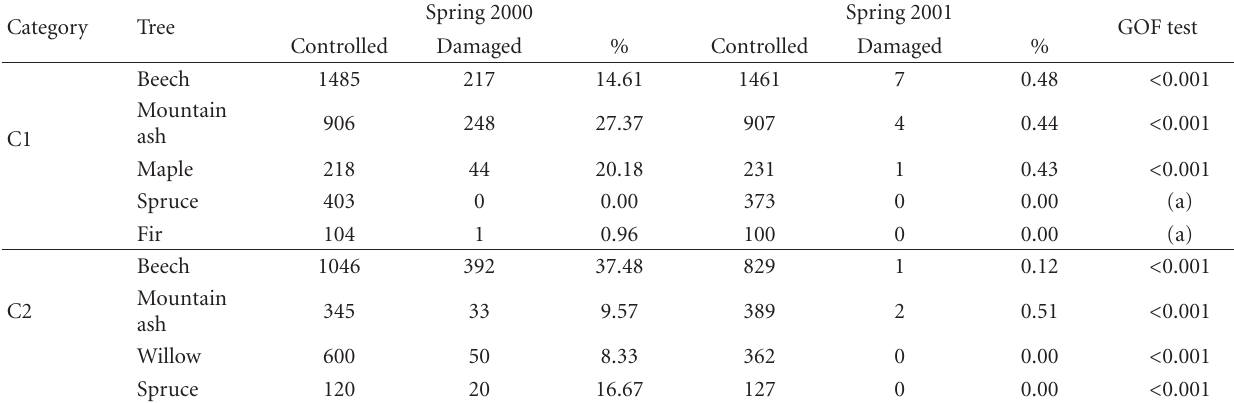
Table 1: Controlled trees (C1: younger; C2: older) in two successive years (after winter 2000 and 2001) and their rodent damage (%). Category